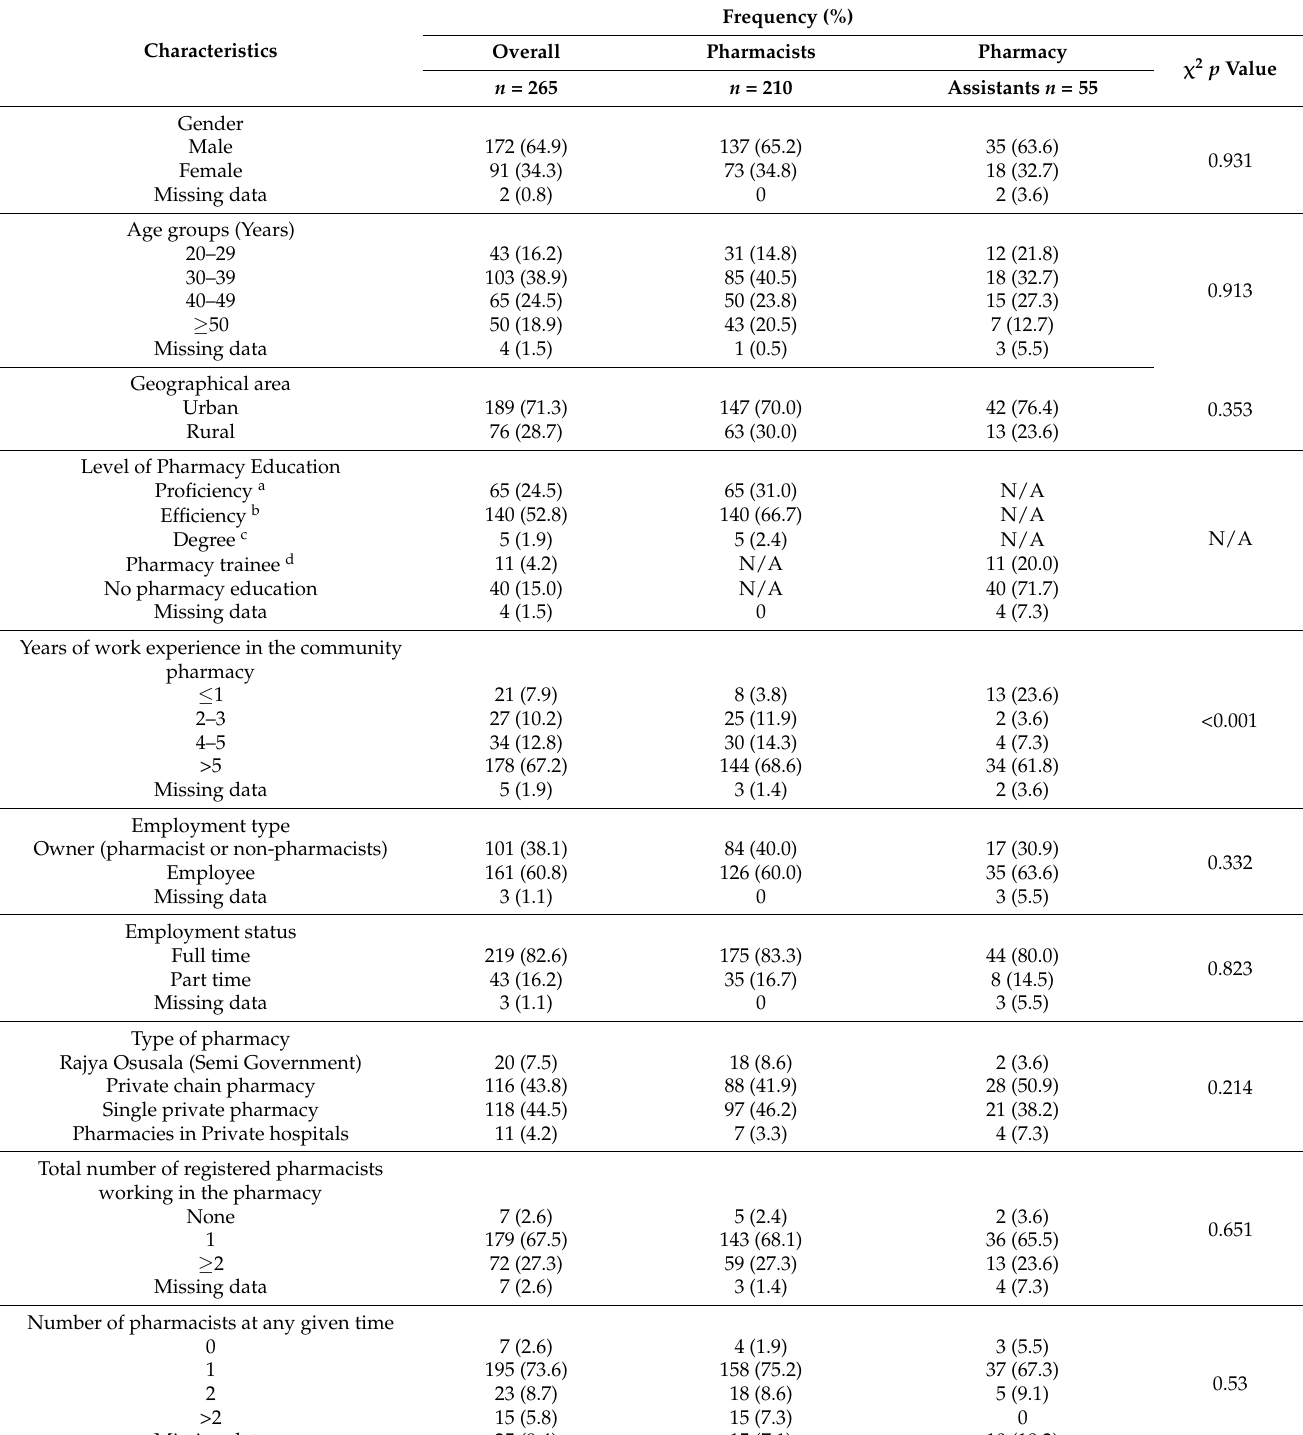
Table 1. Socio-demographic and professional